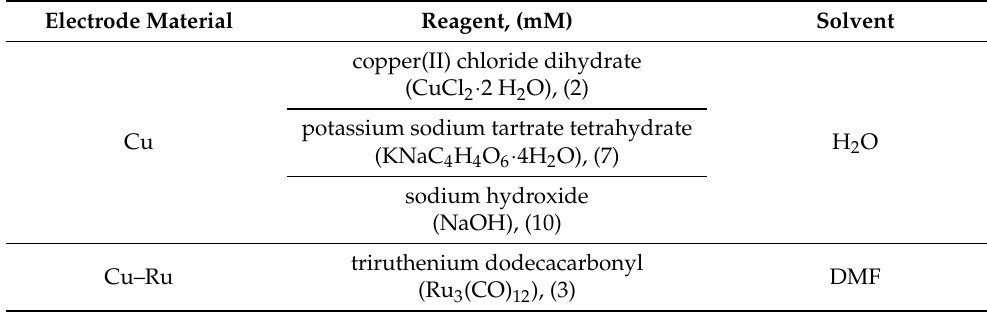
Table 1. Solution components used for laser-induced synthesis of metallic and bimetallic electrodes based on Cu and Ru. Here, DMF is N , N